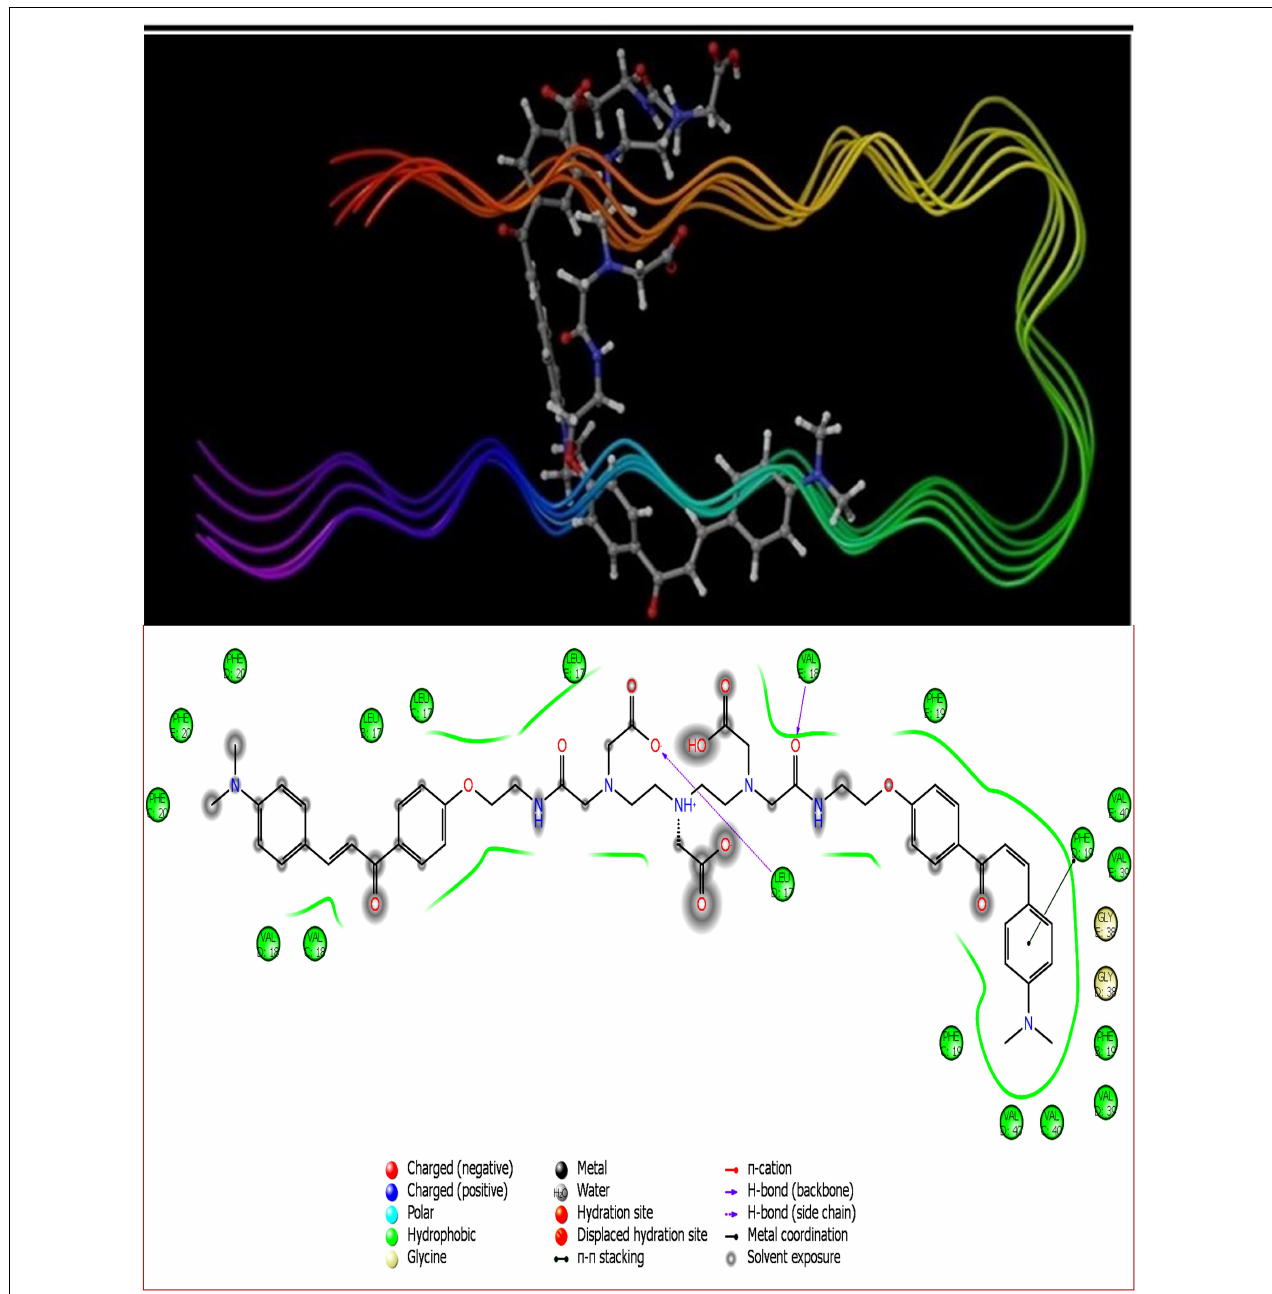
FIGURE 3 | DT(Ch) 2 3D docking pose depicting the 2D and binding view with amyloid-beta fibril